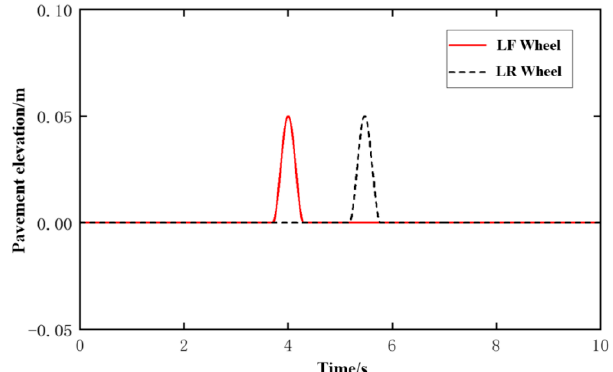
Figure 4. Bump road disturbances on the left front and rear wheels.